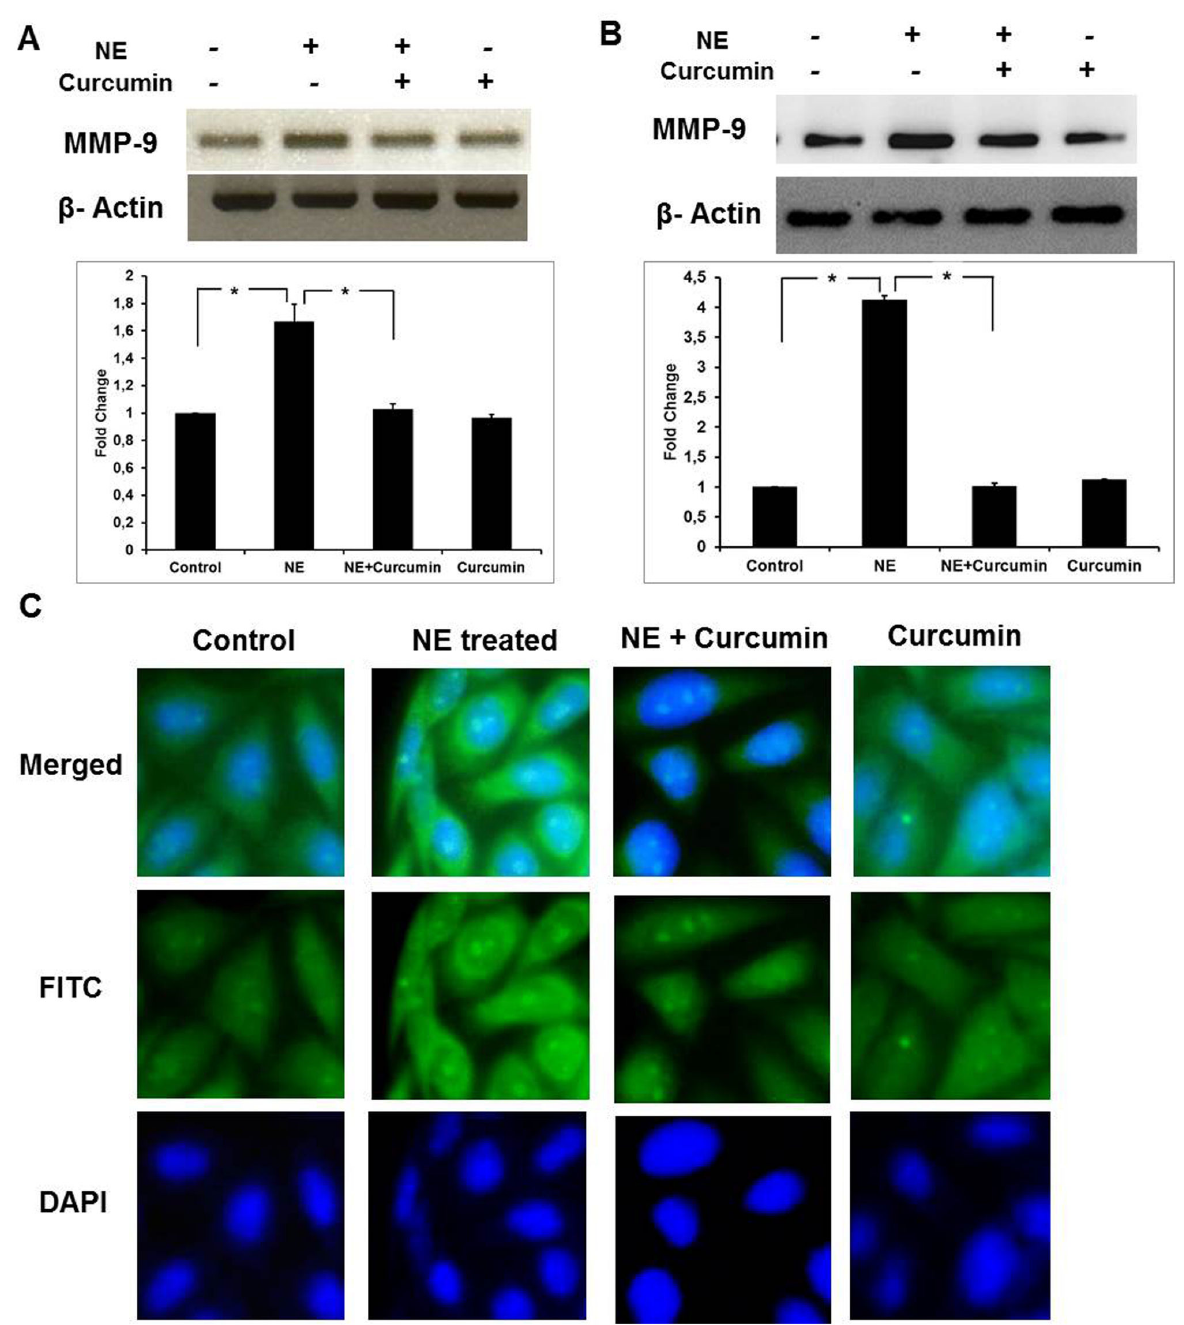
Figure 4. Expression levels of MMP-9 on curcumin treatment. A ) RT-PCR for MMP-9 : mRNA expression seen through semiqunatitative RT-PCR Samples in different lanes starting from the left represented as Lane-1: Control; Lane-2: NE-treated; Lane-3: NE+Curcumin-treated; Lane-4: Curcumin-treated alone. qPCR results obtained were normalized against beta actin and plotted as a histogram (*P<0.05). B ) Western Blotting for MMP-9 : Samples in different lanes starting from the left represented as Lane-1: Control; Lane-2: NE-treated; Lane-3: NE+Curcumin-treated; Lane-4: Curcumin-treated alone. Protein expression observed through Western blotting was quantitated by NIH ImageJ software. Results obtained were normalized against beta actin and plotted as a histogram (*P<0.01). C ) Immunocytochemistry for MMP-9 : Images captured by fluoresencent microscope at 20X magnifications are represented. NE-treated group showed a significant difference compared to control and NE+Curcumin-treated group in all experiments shown in the figure. doi: 10.1371/journal.pone.0076519.g004 PLOS ONE |